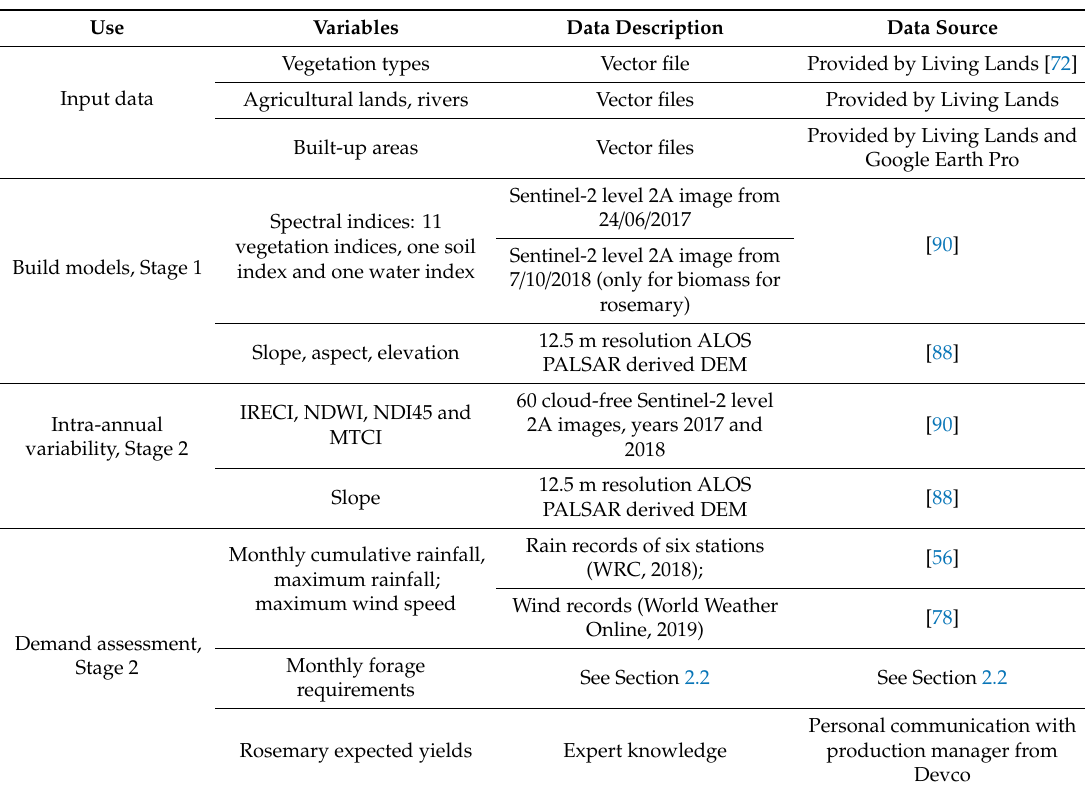
Table 3. Data used in the di ff erent methodological stages as presented in Figure